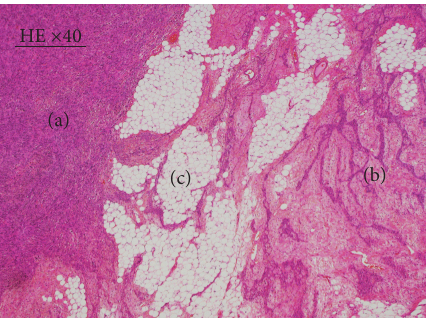
Figure 2: Hematoxylin and eosin (HE) staining findings in Case 1 ( × 40). (a) Plump to thin spindle cells with a low degree of cellular atypia can be observed. (b) Epithelial cells form anastomosing cords. (c) Intermingled adipose cells are present in the